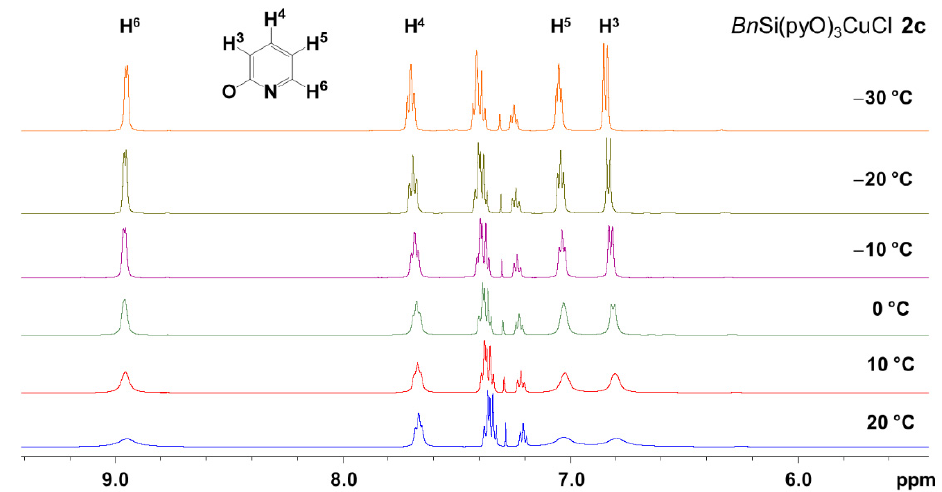
Figure 8. Aryl section of the 1 H NMR spectra of 2c (as solutions in CDCl 3 , all referenced to internal SiMe 4 at 0 ppm) at different temperatures, recorded at 500 MHz.